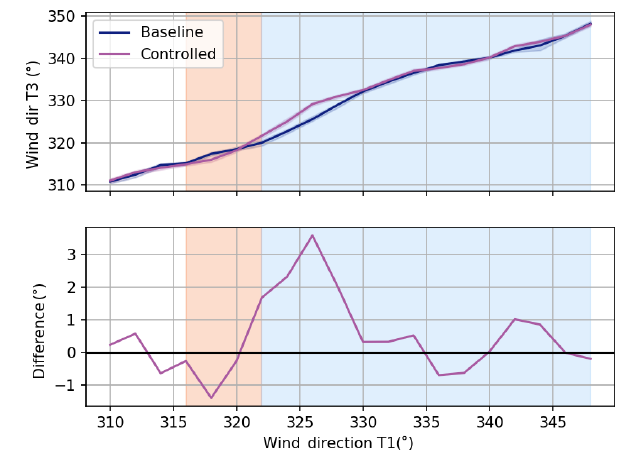
Figure 14. T3’s alignment with the reference wind direction in baseline and controlled conditions indicates an apparent change in wind direction for wind directions with maximal